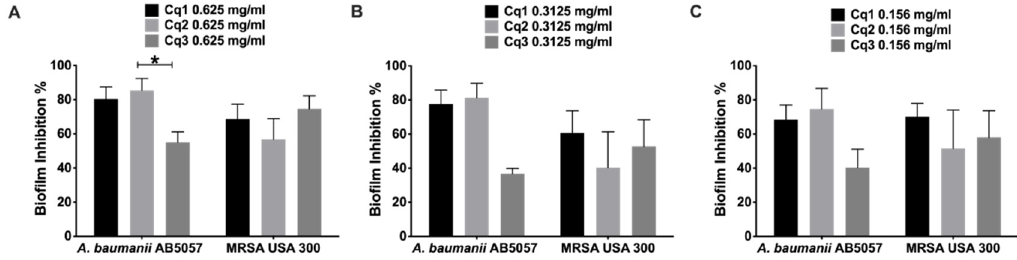
Figure 1. Biofilm inhibition activity. Effect of different concentrations ( A: 0.625 mg/mL, B: 0.3125 mg/mL, and C: 0.156 mg/mL) of Caralluma quadrangula extracts (Cq1, Cq2, and Cq3) against MDRAB AB5057 and MRSA USA300 biofilm formation. Results are expressed as mean biofilm inhibition % ± standard error. * Indicates that the difference is significant at p < 0.05 (two-way ANOVA, Tukey’s post-hoc test).